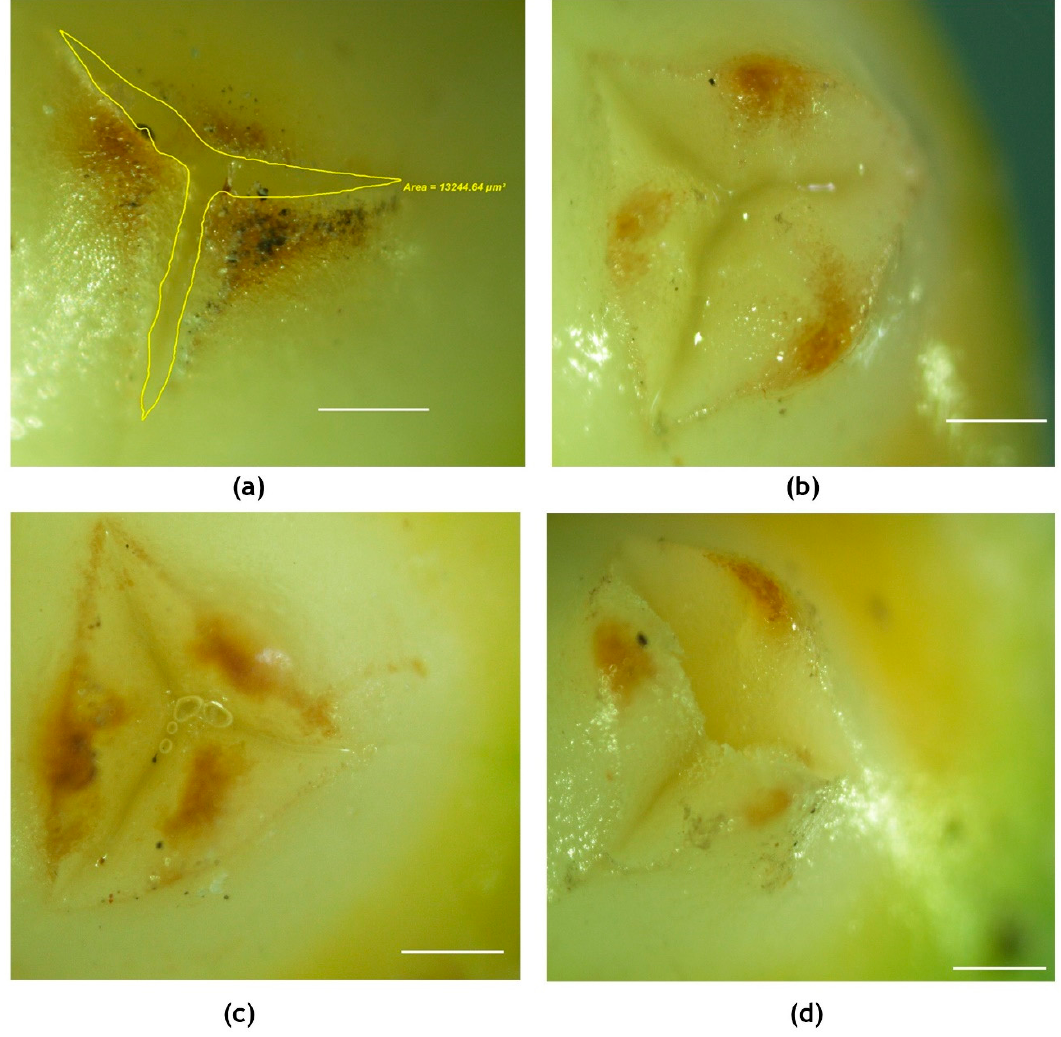
Figure 7. Visualization (2X) of receptive stigma of the coconut variety WCT under ( a ) ambient, ( b ) chamber control, ( c ) chamber with 3 ◦ C rise in temperature and 55 + 5% RH and ( d ) chamber with 3 ◦ C rise in temperature and 65 + 5% RH. The area in-between the opening of perianth lobes was measured as shown in (a) using a stereo microscope. Scale bar = 100 μ m.